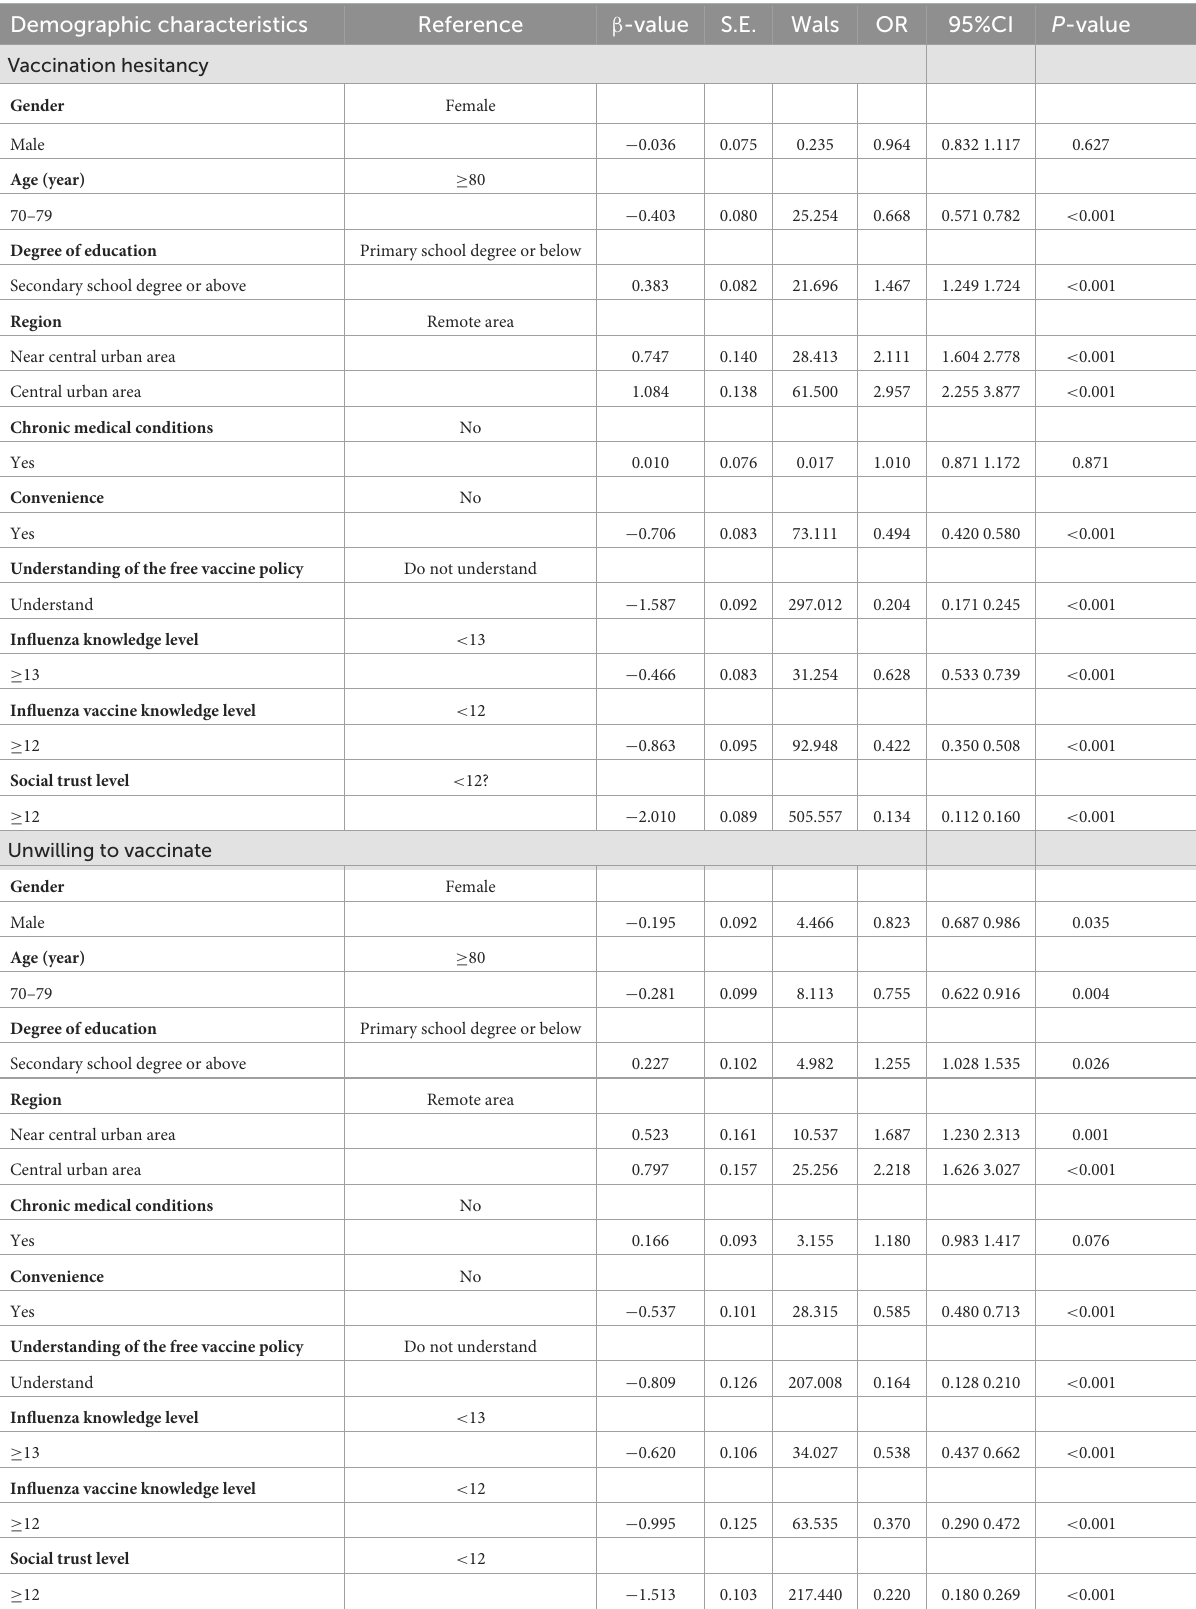
TABLE 4 Multivariate analysis of willingness to receive free influenza vaccine among the elderly aged 70 and above in Hangzhou. Demographic